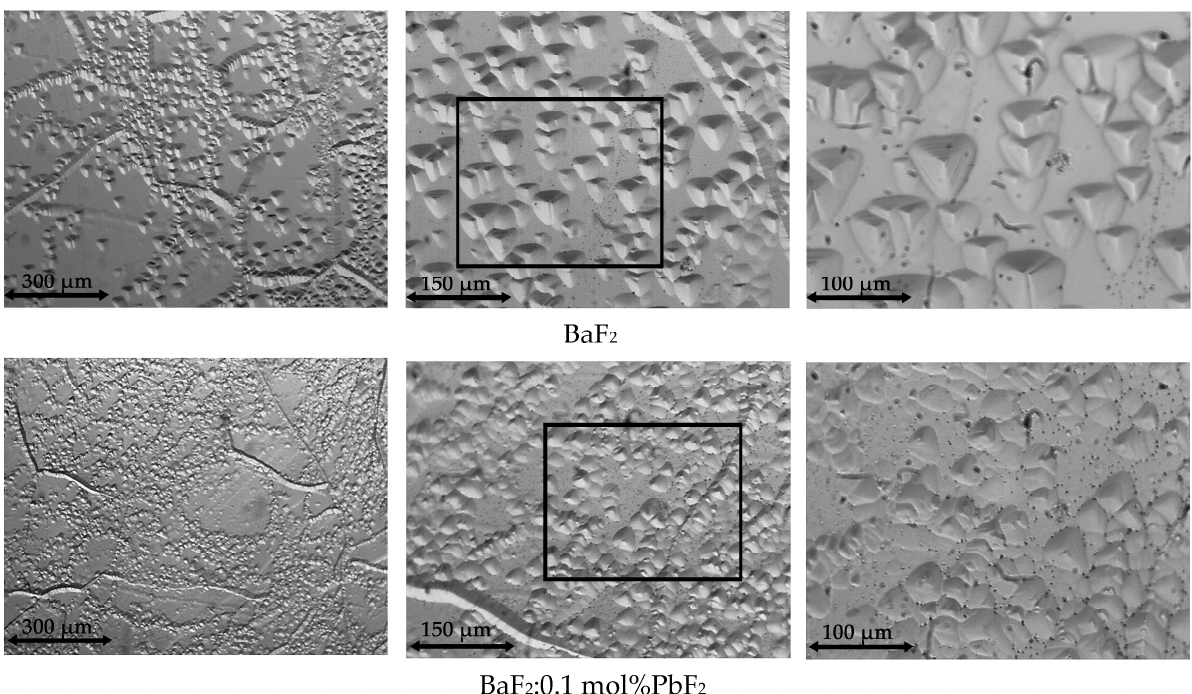
Figure 2. Dislocation etch pits on the (111) cleavage plane of BaF 2 and BaF 2 :0.1 mol% PbF 2 crystals.